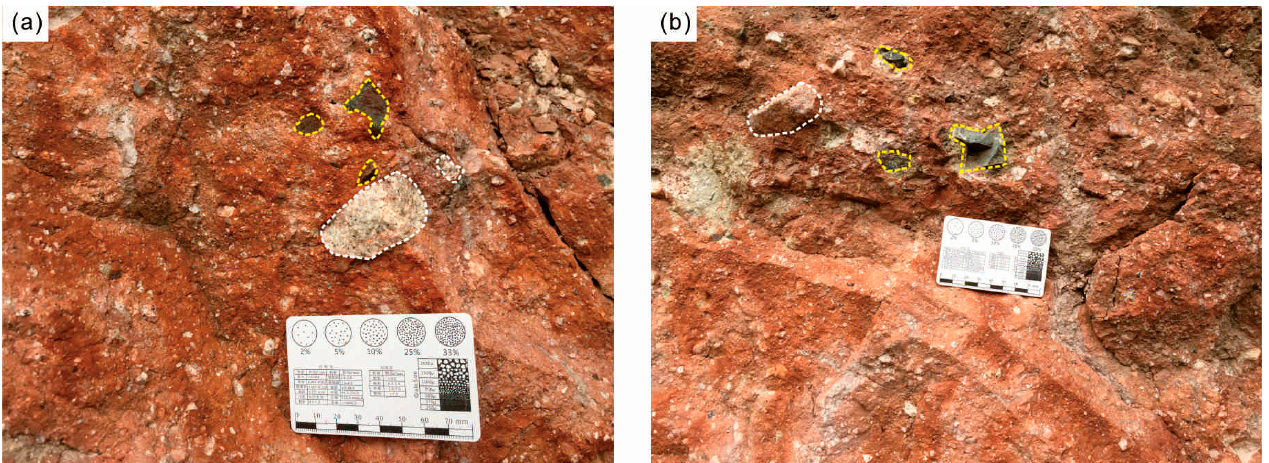
Figure 8. Field photographs of Upper Cretaceous Fengzhou Basin conglomerates from two locations, ( a , b ), in the Lujing uranium ore field. Several large clasts of metamorphosed sandstone and granite are highlighted by the yellow and white dashed lines, respectively. Scale bar on card in both photographs is 8 cm in length.